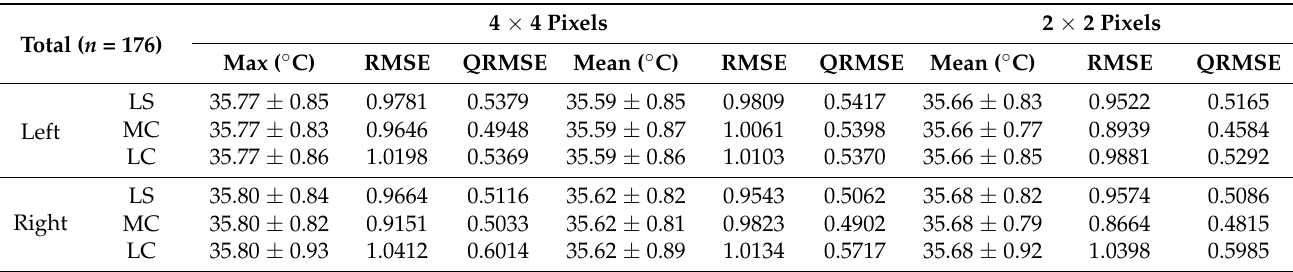
Table 4. Maximum, mean temperature, root mean square error (RMSE), and quantile RMSE (QRMSE) results of three ROIs in the horse’s eyes for each rectal temperature (RT, ◦ C) after statistical bias